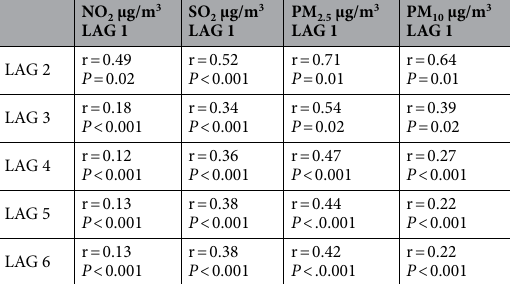
Table 5. Pearson’s correlations between air pollution concentration at LAG 1 and LAG 2–6. Abbreviations : NO 2 , nitrogen dioxide; PM 2.5 , particulate matter with a diameter of 2.5 μm or less; PM 10 , particulate matter with a diameter of 10 μm or less; SO 2 , sulfur